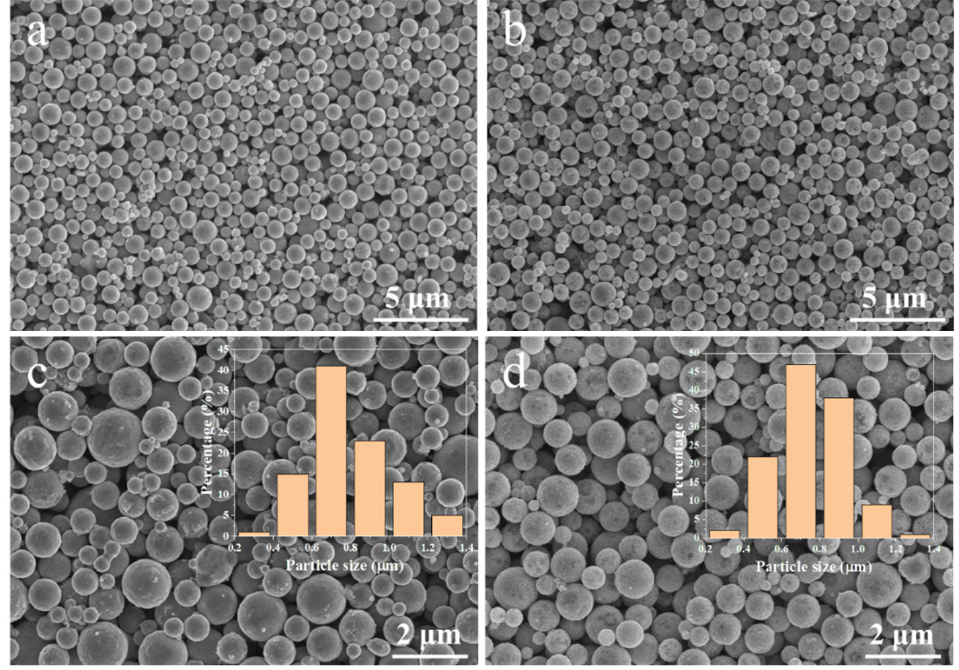
Figure 4. SEM images of ( a , c ) the as-synthesized Cu NMPs and ( b , d ) the as-synthesized Cu@Ag NMPs. The inserted figures show the particle size distribution.